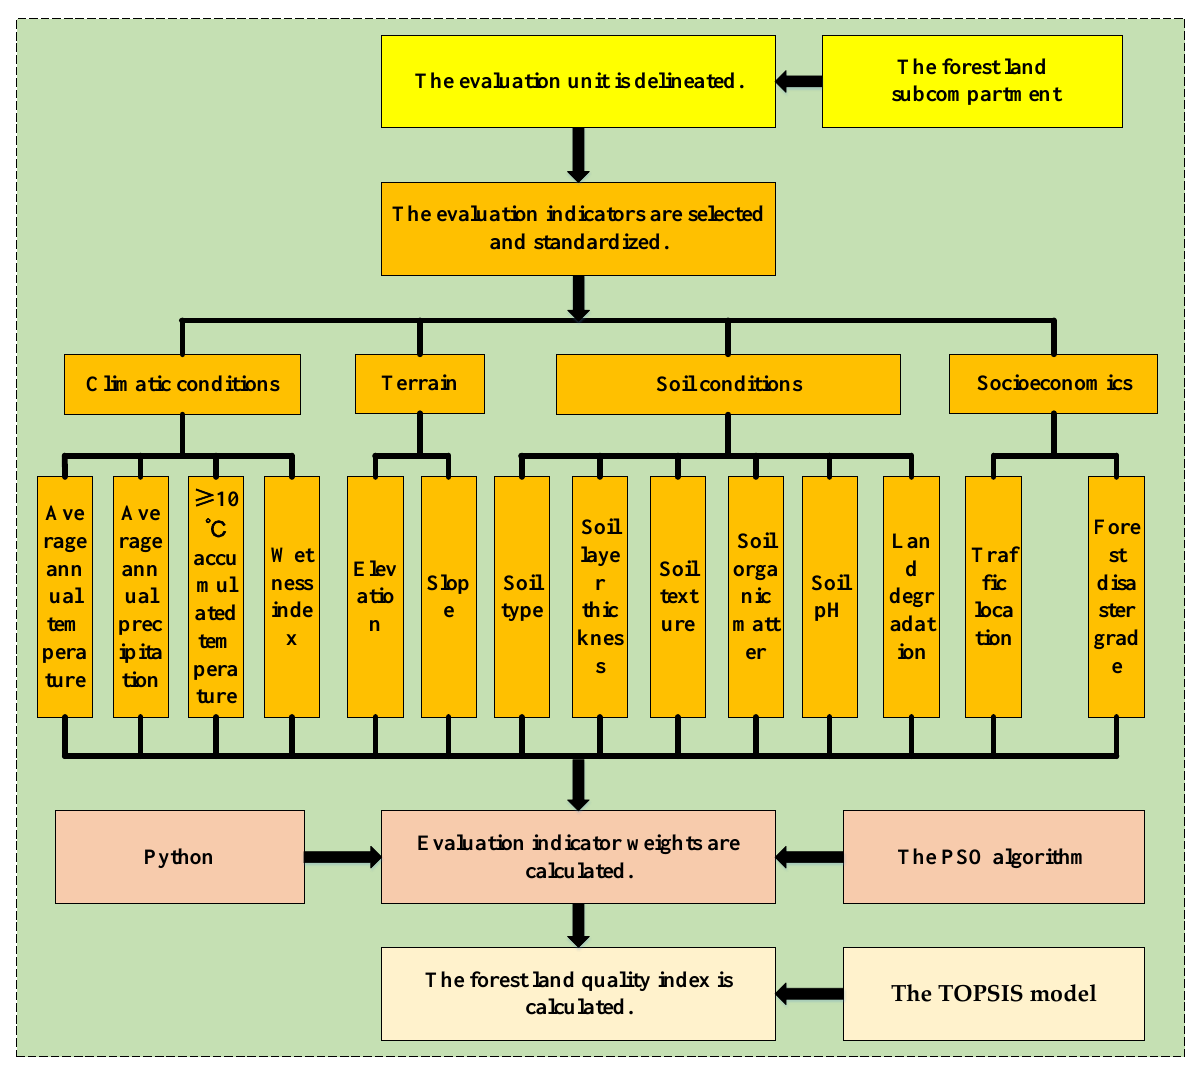
Figure 2. The process of evaluation index system construction. Note: PSO is the abbreviation of Particle Swarm Optimization. TOPSIS is the abbreviation of Technique for Order Preference by Similarity to Ideal Solution. Table 1. Forest land quality evaluation indicator grading standards and their scores.